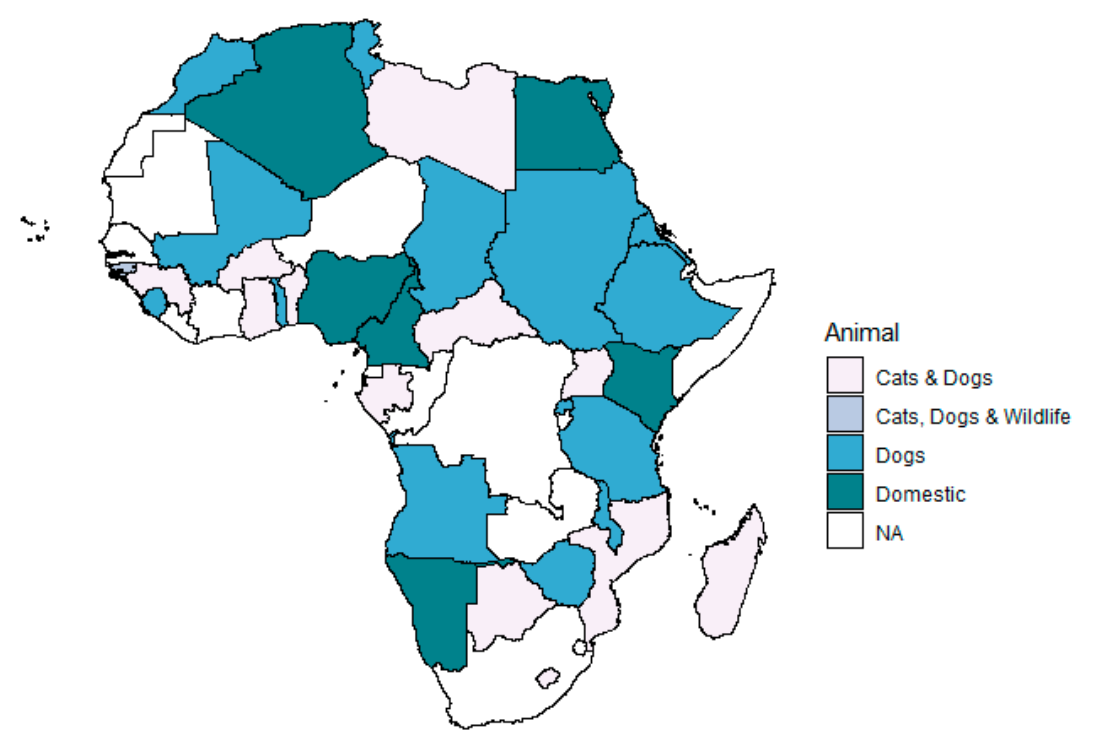
Figure 1. Official rabies vaccination program in Africa by 2019. NA: not available, represents countries with no official plan or no data retrieved. Domestic refers to animals that live in contact with and under control of or owned by humans and summarizes here species including buffalo, cattle, goats, pigs, rabbits, and sheep; see details per country in Table 1; Wildlife refers to animals that grow and live in the wild [18].